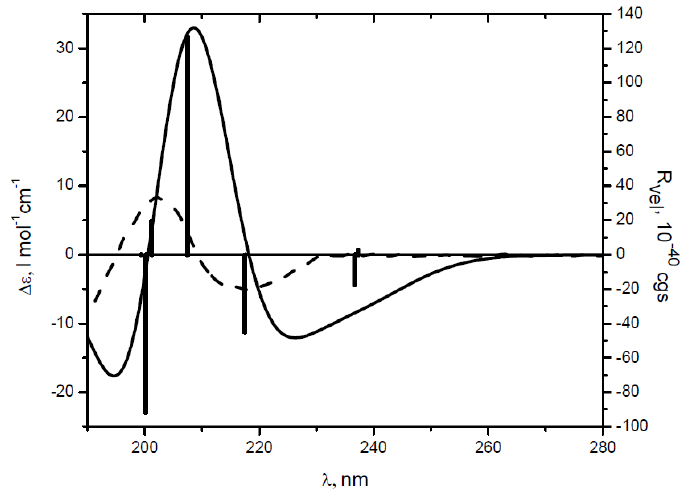
Figure 3. Comparison of the calculated (solid) and experimental (- - ) CD spectra of dinitrile 3 at the B3LYP/aug-cc-pVDZ level ( σ = 0.30 eV); bars represent the rotatory strength.